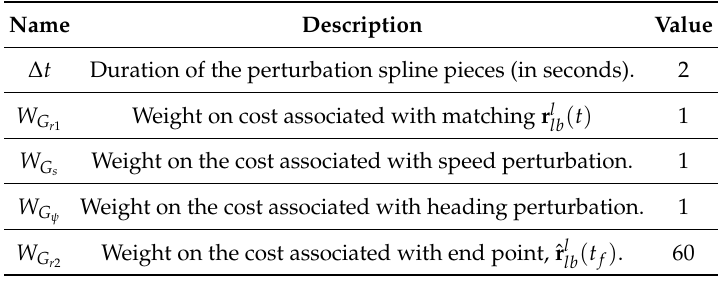
Table 4. Hyperparameters for Ground Truth